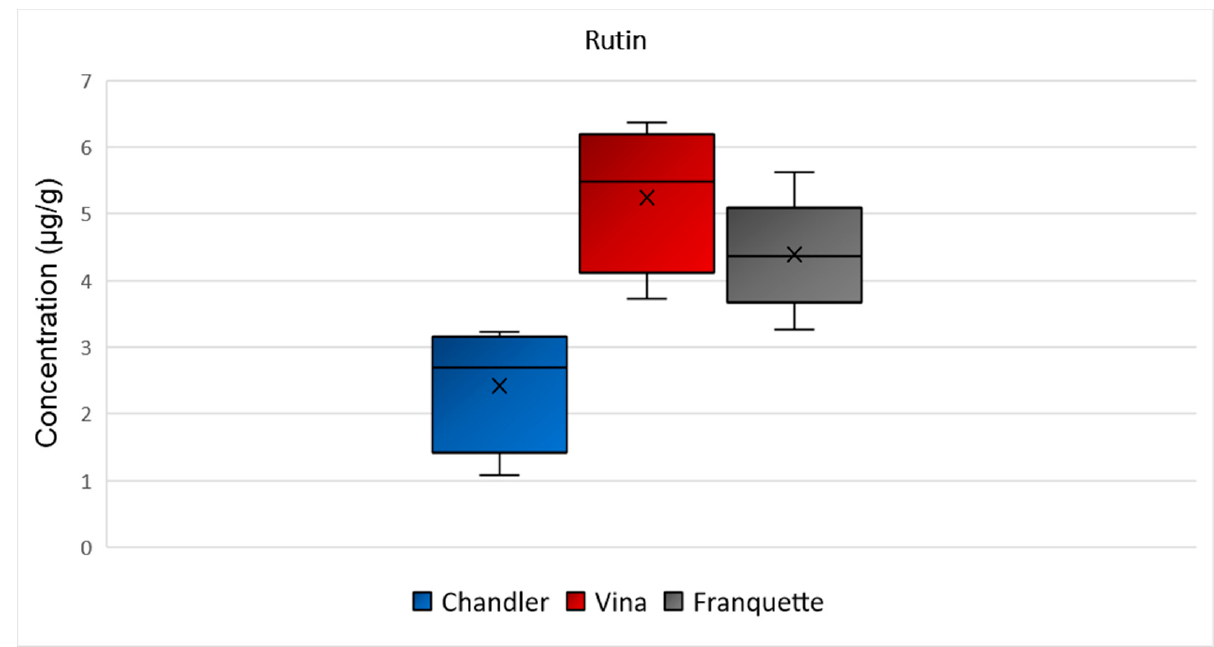
Figure 3. Box and Whisker plot for the concentration of rutin among walnut septa belonging to the Chandler, Vina, and Franquette varieties.